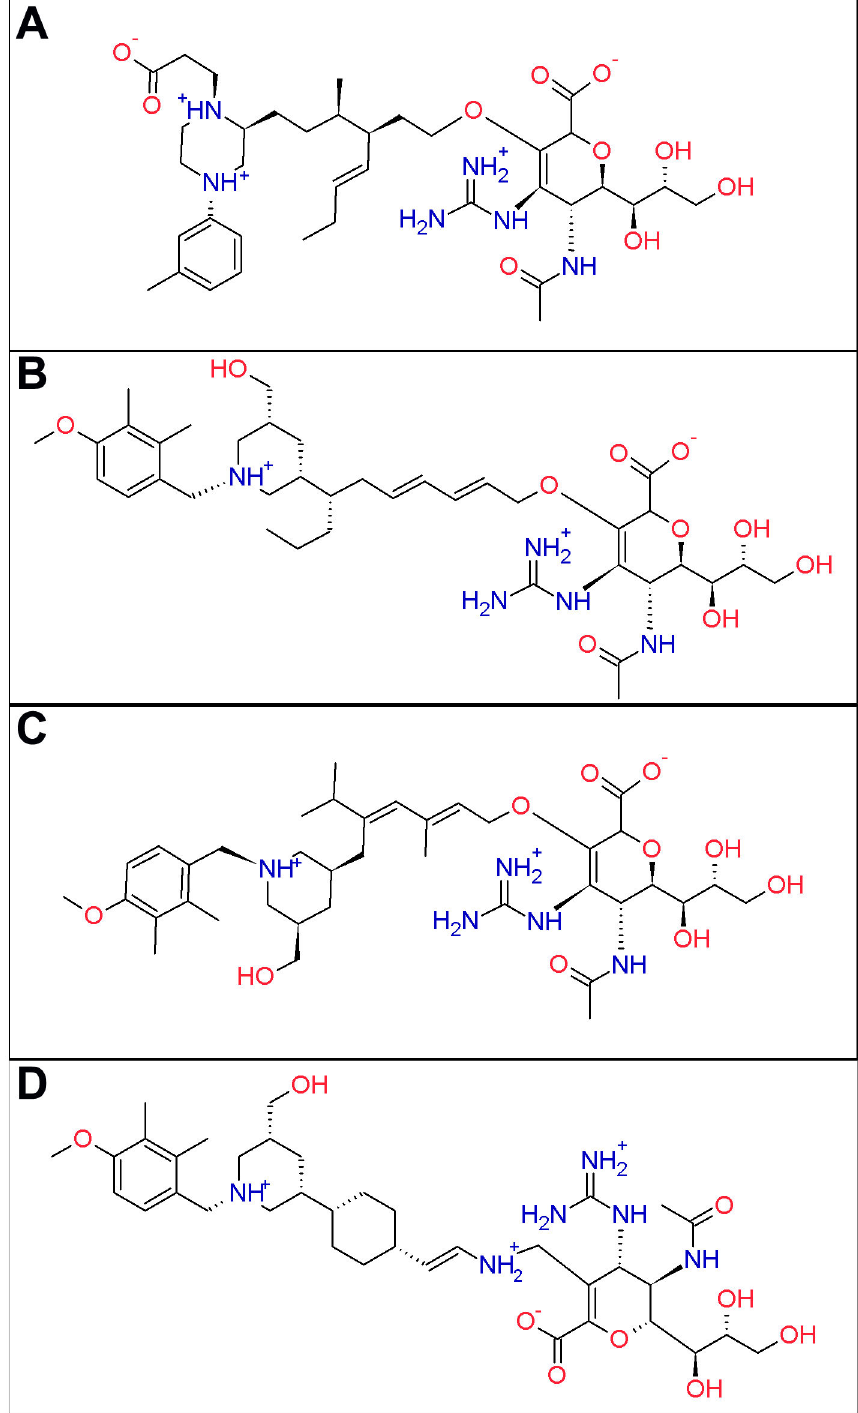
Figure 6. Two-dimensional structures of Lig1-4. Two-dimensional structures of Lig 1-4 are shown in panels A-D, respectively.